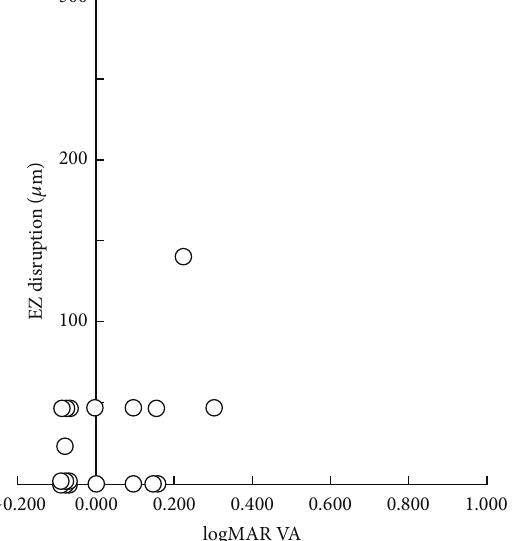
Figure 3: Scatter plot of logMAR VA and diameter of the EZ dis- ruption at the 1-year postoperative visit. There was no significant correlation( 𝑟 𝑠 = 0.307 , 𝑃 = 0.201 ;Spearman’scorrelationcoefficient